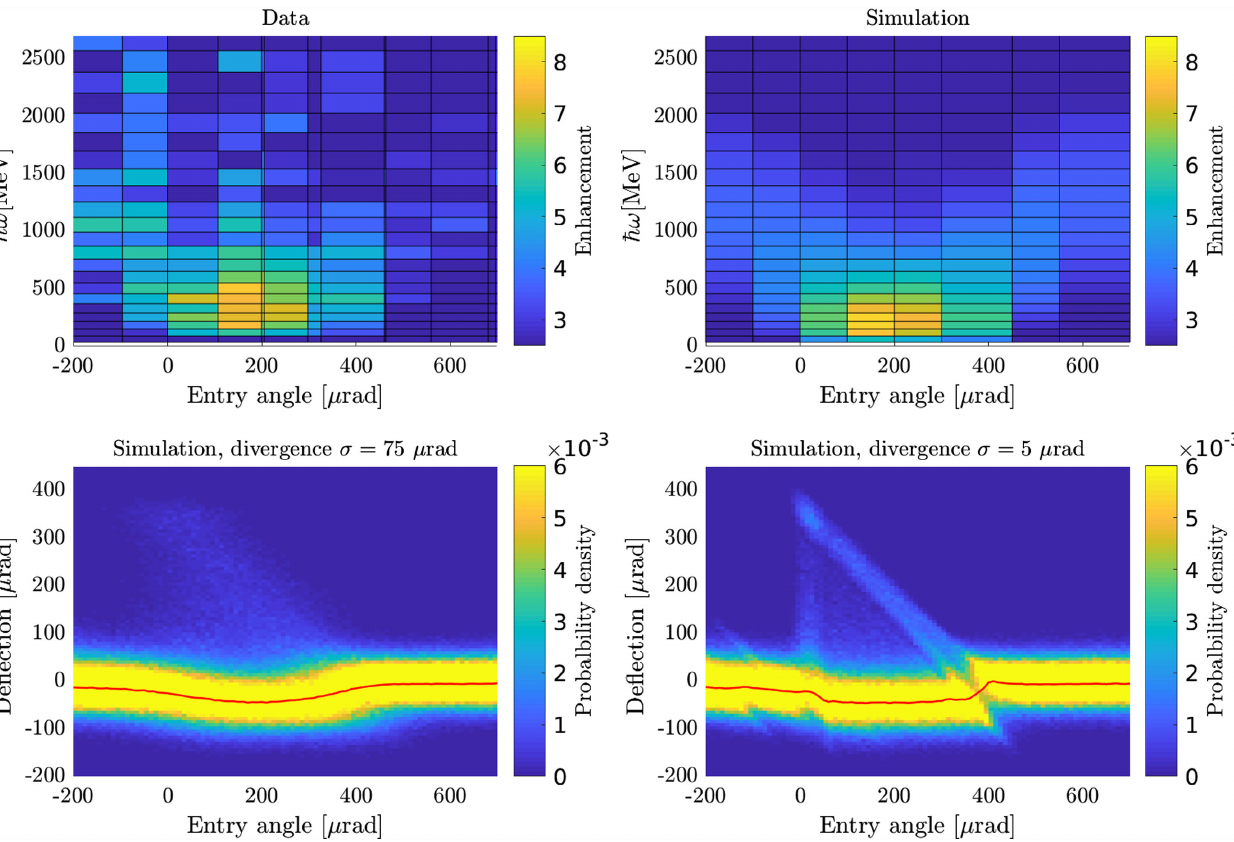
FIG. 6. Radiation and deflection spectra from 12.6 GeVelectrons with different entry angles with respect to the (111) plane of a 60 μ m thick bent silicon crystal. The top left figure is the experimental radiation spectra and the top right figure is the simulated radiation spectra for electron beams with a beam divergence of σ ¼ 75 μ rad. The bottom figures are the simulated angular deflection of electrons for beams with different entry angles and beam divergences. The red line is the centroid of the lower